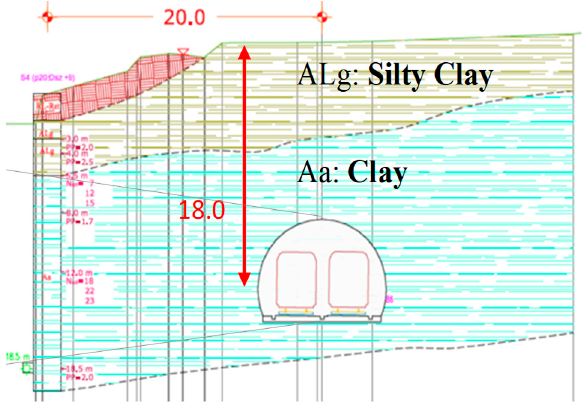
Figure 1. The real cross ‐ section referring to a segment of the underground railway in Catania (Italy).